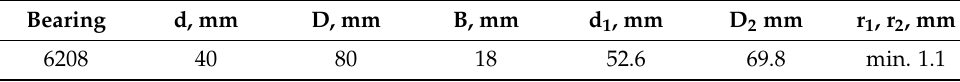
Table 2. Bearing specifications 6208.